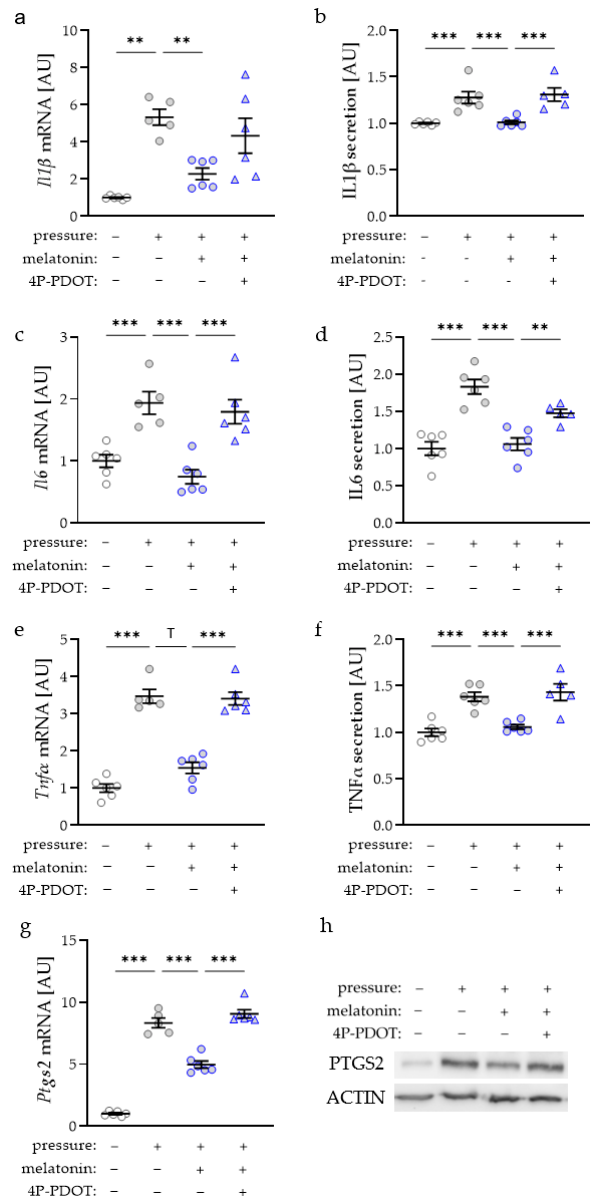
Figure 3. Impact of melatonin and compressive strain on gene and protein expression of interleukin- 1-beta (IL1 β ; a , b ), IL6 ( c , d ), tumor necrosis factor alpha (TNF α , e , f ), or prostaglandin endoperoxide synthase-2 (PTGS2, g , h ) in macrophages; uncropped blot is presented in Figure S2. n ≥ 5; Statistics: ordinary ANOVA with Holm – Sidak´s multiple comparison tests except for Il1 β , Tnf α and Ptgs2 mRNA (Welch-corrected ANOVA with Games – Howell multiple comparison tests); T p < 0.10; ** p < 0.01, *** p < 0.001.